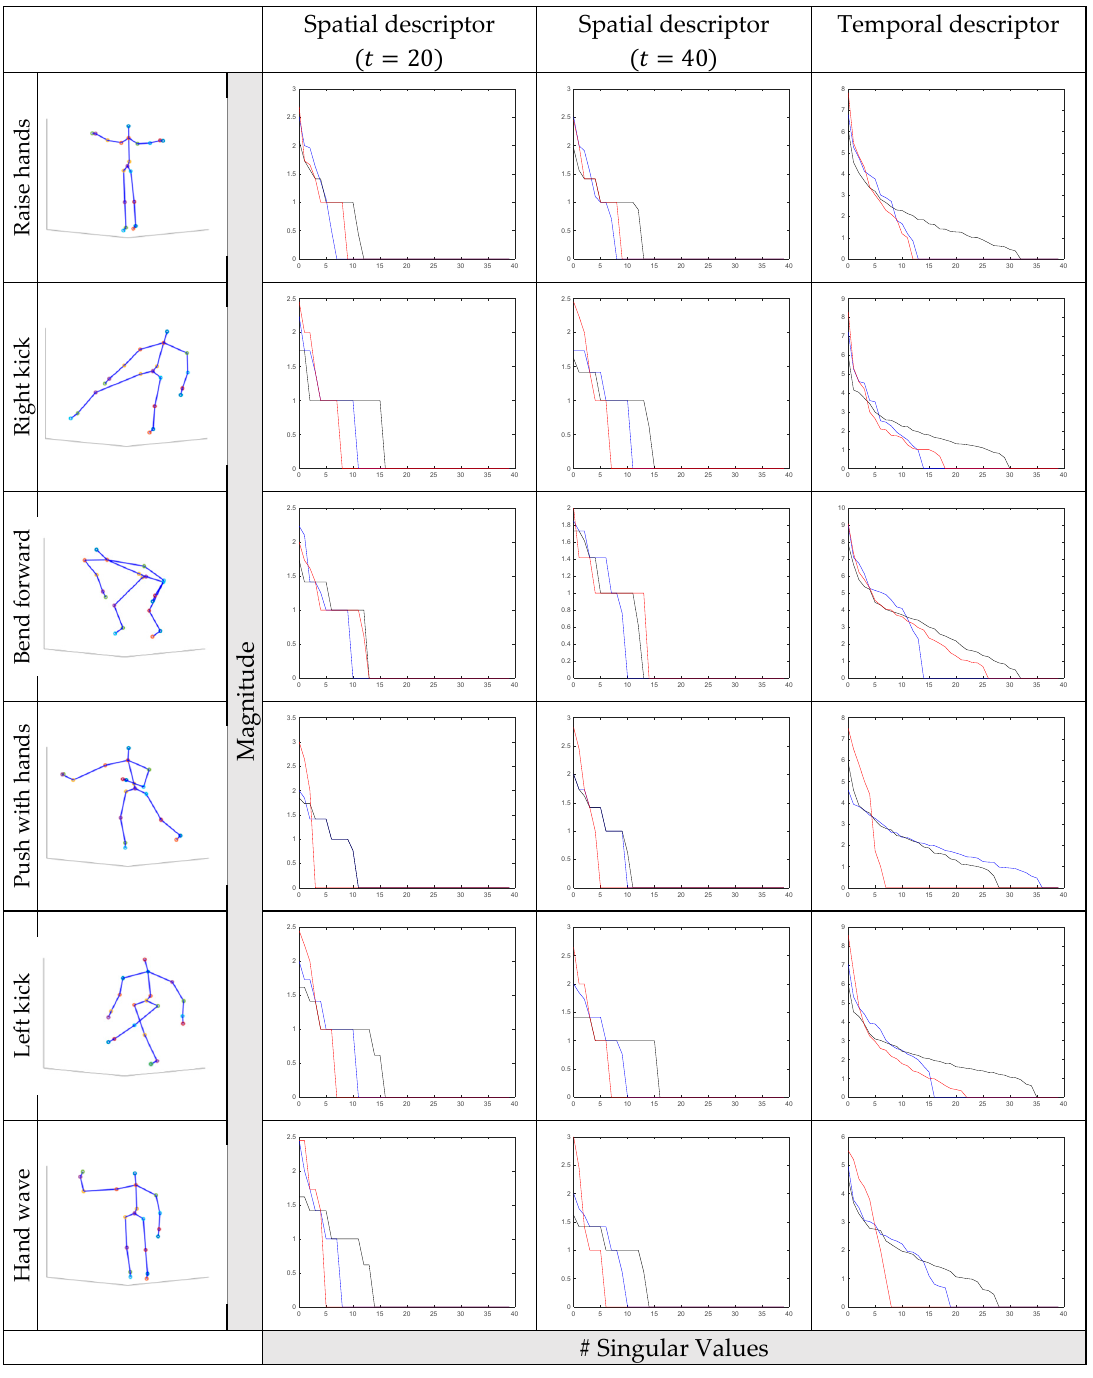
Figure 3. Distributions of three mode singular values (SVs) for the different human actions of CERTH [32] database. In the two first columns, the proposed spatial descriptors for 𝑡 = 20 and 𝑡 = 40 are shown. In the third column the proposed temporal descriptor is shown. The blue line corresponds to the 𝑚𝑜𝑑𝑒 − 1 SVs, the black line to the 𝑚𝑜𝑑𝑒 − 2 SVs and the red line to the 𝑚𝑜𝑑𝑒 − 3 SVs.